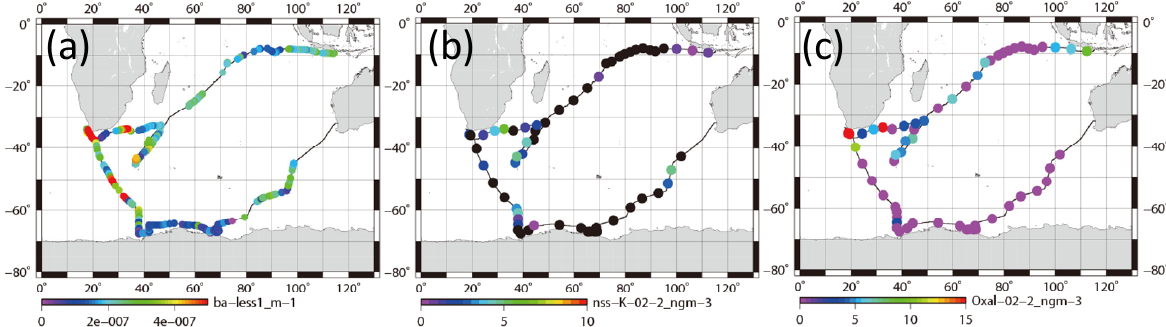
Figure 7. Horizontal variation of (a) absorption coefficient of particles smaller than 1µm, (b) mass concentration of nss-K + for 0.2–2µm aerosols, and (c) mass concentration of oxalate for 0.2–2µm aerosols. Black circles show values below the detection limit.